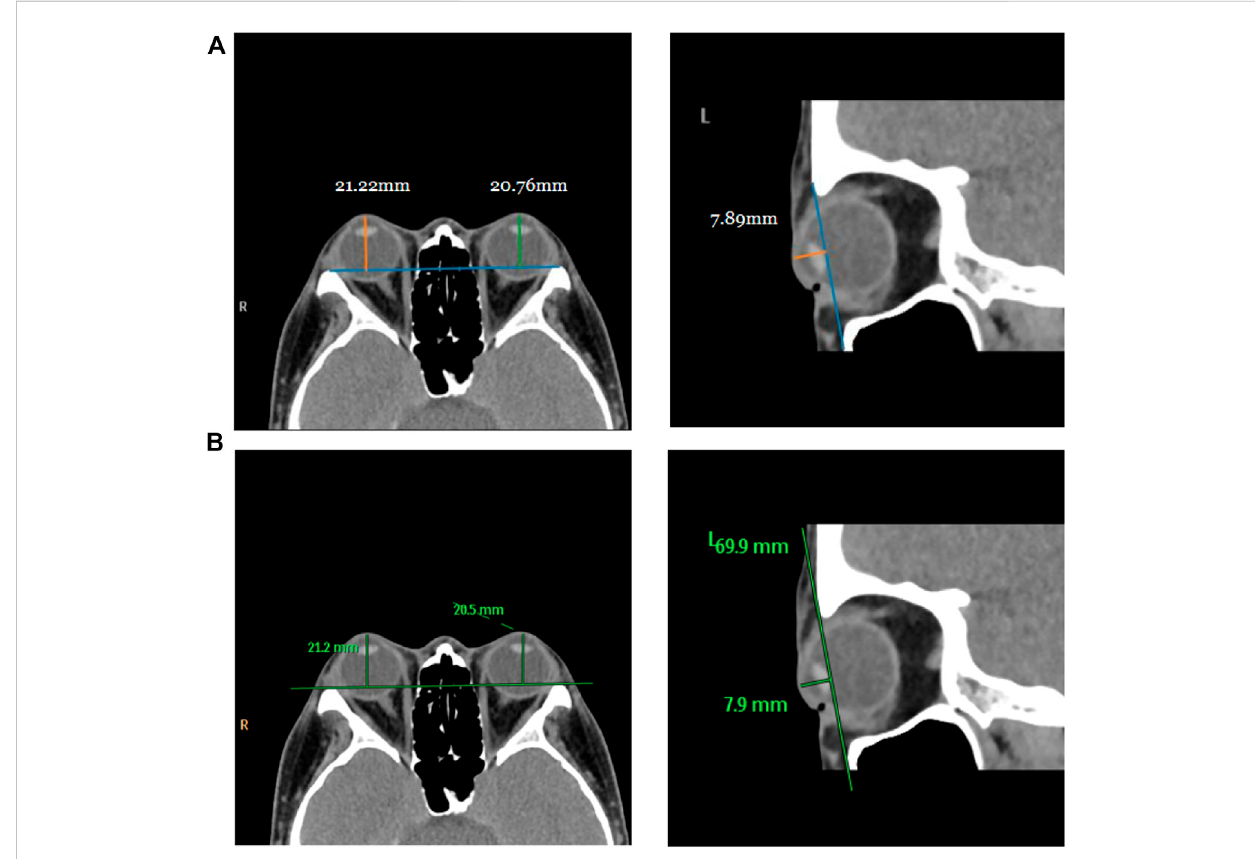
FIGURE 8 Visualization of measurement results of the proposed automated method and the manual measurement method by the physician on the test set. Row (A) representsthevisualizationresultofmeasurement usingtheproposed method,androw (B) isthevisualizationresultofmanualmeasurementby the physician on the same image.